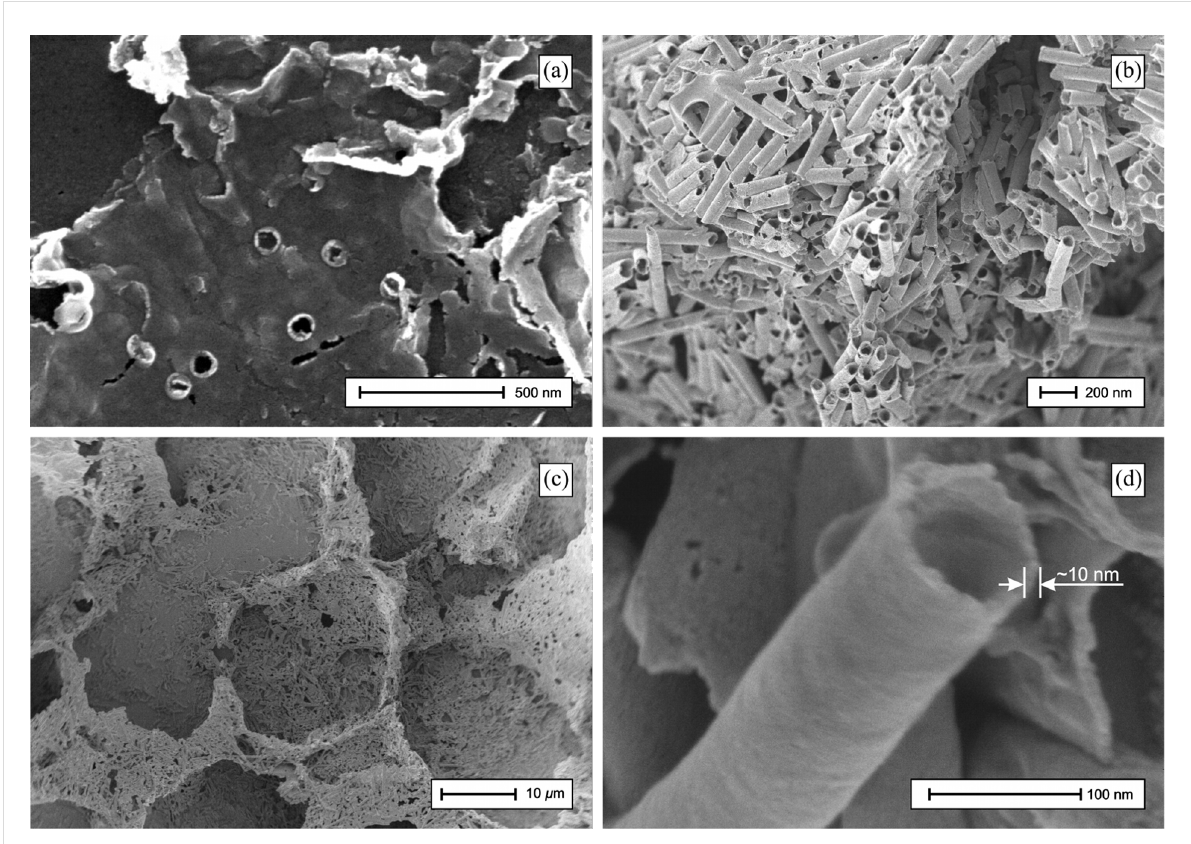
Figure 1: (a) SEM image of the removed ITO layer from the template surface. (b)–(d) SEM images of bulk ITO-NTs freed from the polycarbonate